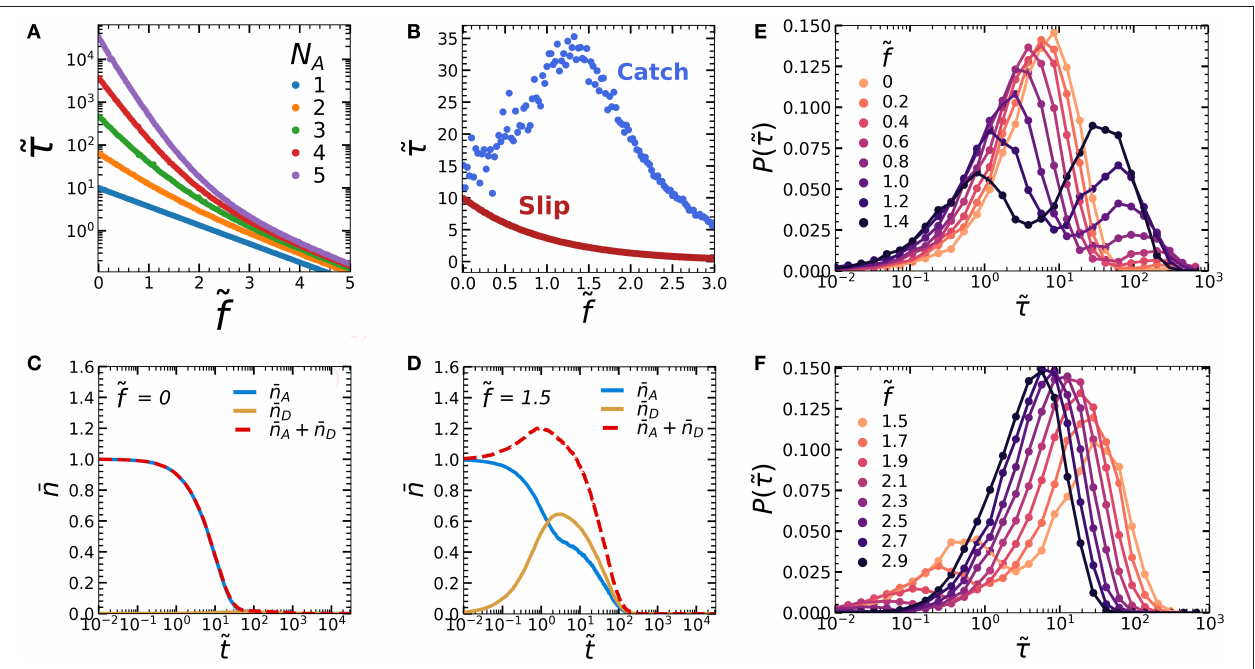
FIGURE 2 | (A) Force-lifetime curve of an oligomer consisting of a varying number of subunits ( N A ), without a mechanophore ( N C = 0). (B) Force lifetime curves of a single N A = 1 oligomer displays slip bond behavior in the absence of a mechanophore (red curve, N C = 0) and catch bond behavior in the presence of a mechanophore (blue curve, N C = 1). (C,D) Kinetic diagrams of the blue curve in figure b showing the average number of bonds in the A and D states ( ¯ n A and ¯ n D ) over simulation time steps ˜ t at ˜ f = 0 (C) and around maximum lifetime, at ˜ f = 1.5 (D) . (E,F) Logarithmically binned histograms of the bond dissociation times ˜ τ at different forces for (E) ˜ f < 1.5 and (F) ˜ f > 1.5. Simulations were run with zero-force rate constants k AB ,0 = 0.1, k CD ,0 = 0.001, k DE ,0 = 0.01 and activation lengths δ x c = 4.6, and δ x D = δ x A =